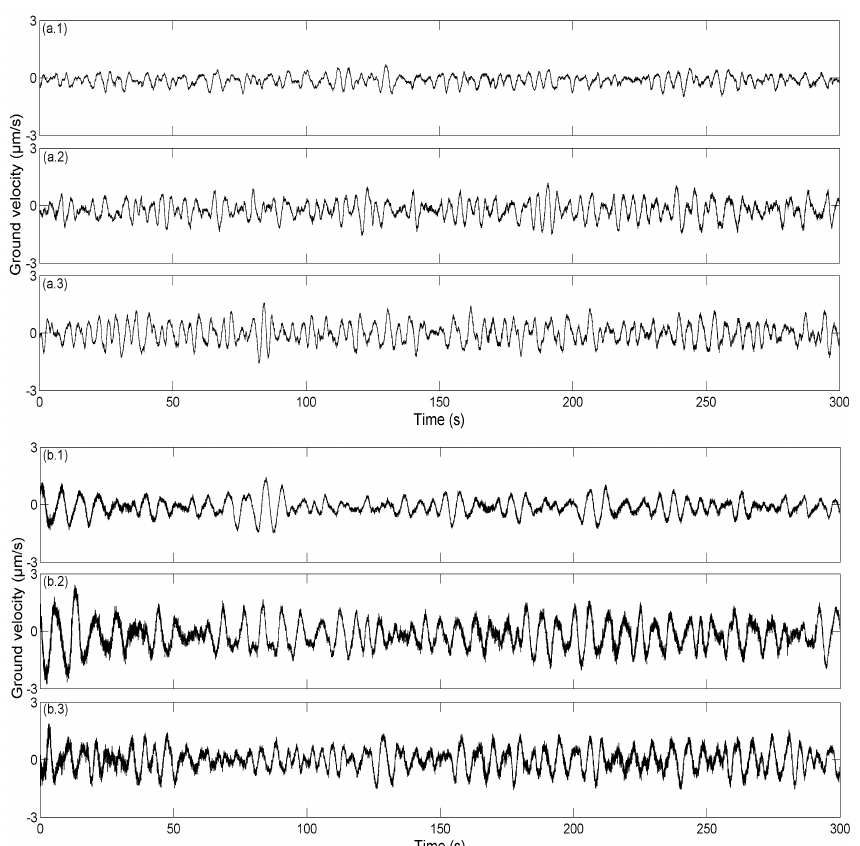
Fig. 2. Examples of two time series (raw signals, COCA station) recorded on (a) 08/12/2005 13:00 (a.1 vertical, a.2 EW and a.3 NS component) and (b) 05/03/2006 17:00 (b.1 vertical, b.2 EW and b.3 NS component) are plotted. Differences in amplitude and dominant spectral content between the two examples appear.